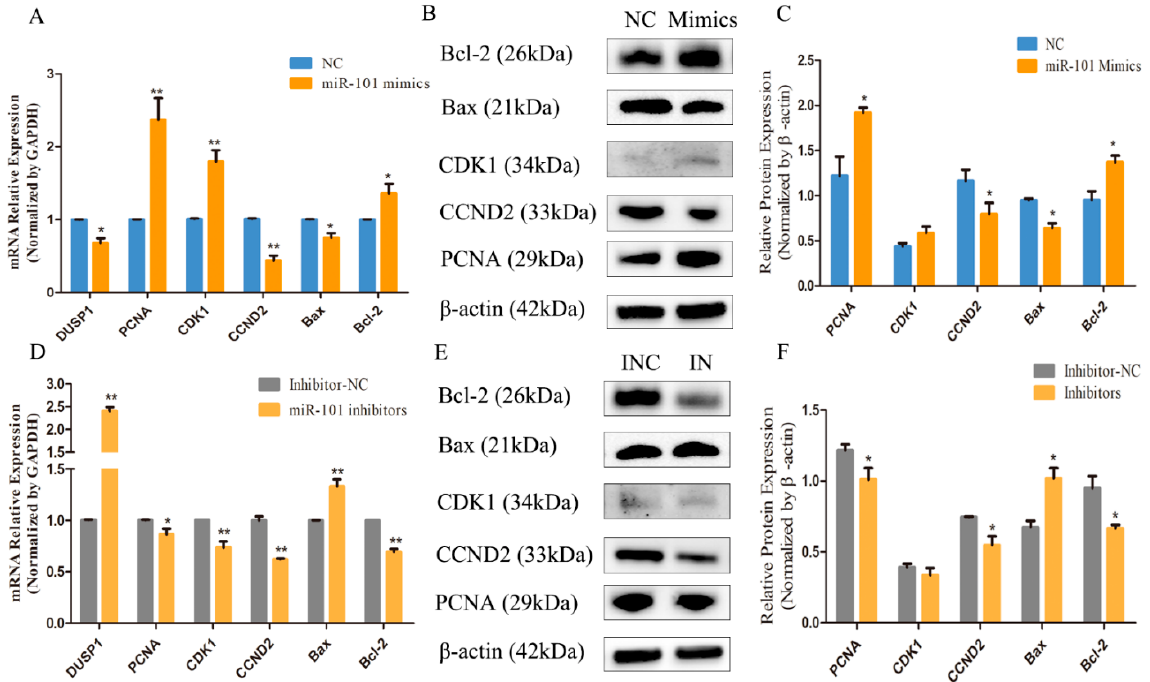
Figure 4. Effect of miR-101 on the expression levels of proliferation and apoptosis-related genes and proteins: ( A , D ) The mRNA expression of DUSP1 , proliferation-related genes ( PCNA , CDK1 and CCND2 ) and apoptosis-related genes ( Bax and Bcl2 ) at 48 h, after being transfected with NC, miR-101 mimics, inhibitor NC and miR-101 inhibitors, were determined by RT-qPCR. GAPDH was used as an internal control; ( B , E ) Protein expression of proliferation-related genes ( PCNA , CDK1 and CCND2 ) and apoptosis-related genes ( Bax and Bcl2 ) at 48 h, after being transfected with NC, mimics, INC and inhibitors, were determined by Western blotting; ( C , F ) The relative expression of related proteins from each group are shown as the mean ± SEM, which were obtained from at least three independent replicates (independent-samples t-tests). No asterisk, p > 0.05; *, p < 0.05; **, p < 0.01.